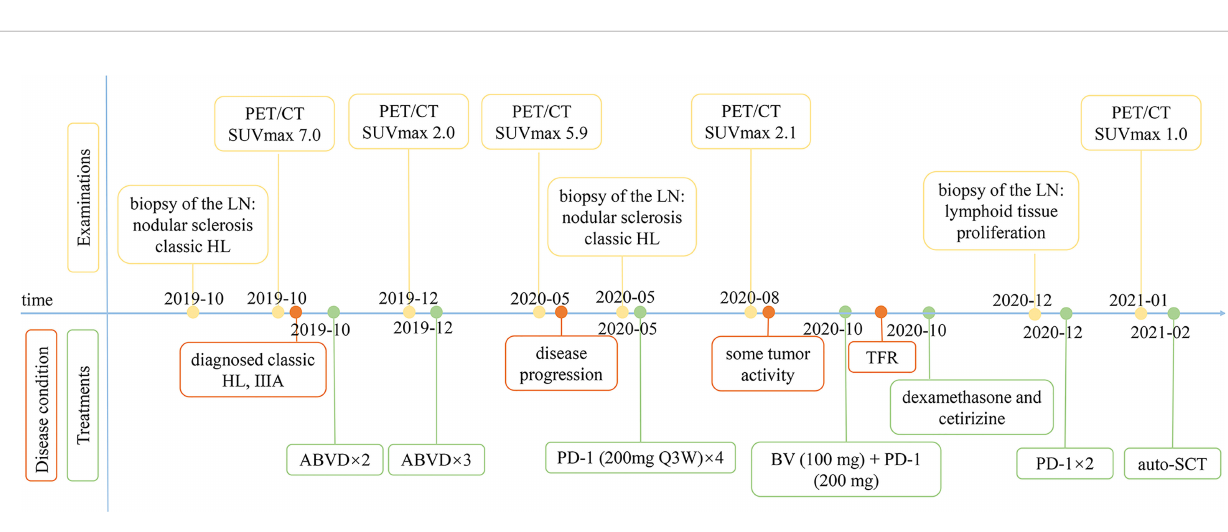
FIGURE 4 | Clinical course of the patient. US, ultrasound; LN, lymph node.